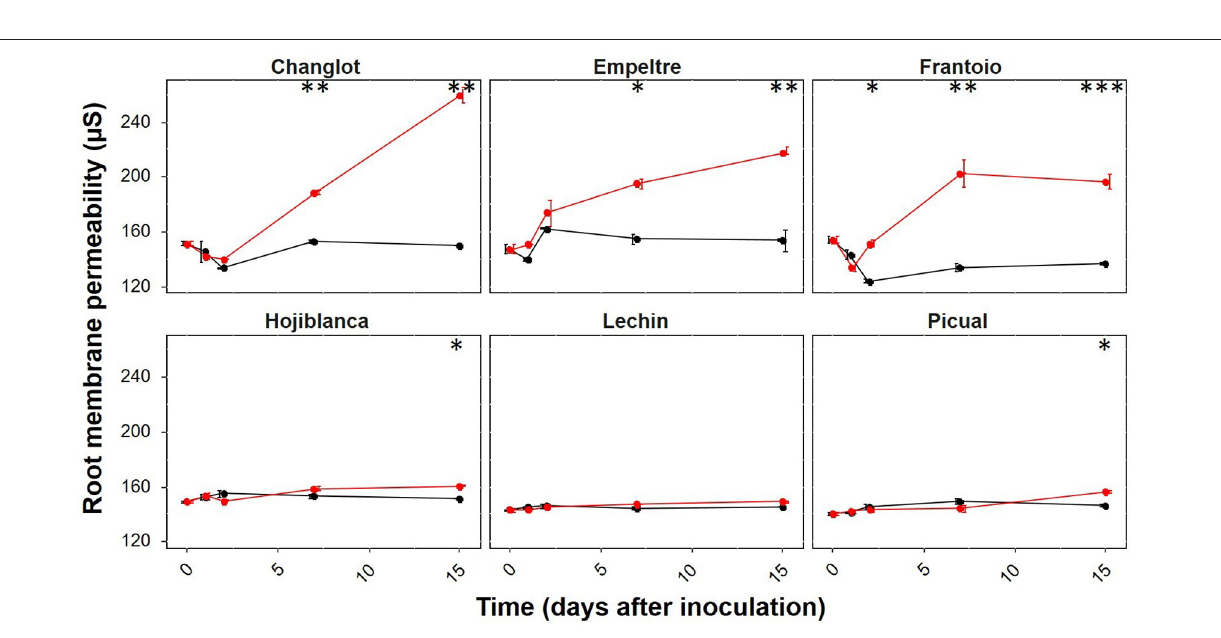
FIGURE 7 | other two panels data are the average ( n = 3) for each sampling time. Control (non-inoculated) plants are represented in white color and V. dahliae -inoculated plant in light blue for tolerant cultivars and in orange for the susceptible ones. The error bars correspond to the standard deviation (SD). The differences analyzed with Tukey’s post hoc test ( p < 0.05) are represented in black letters among the control plants and in red letters among the pathogen-inoculated plants. The statistical differences resulted by the ANOVA analysis between the control and inoculated plants are represented by asterisks (level of significance: *, p <